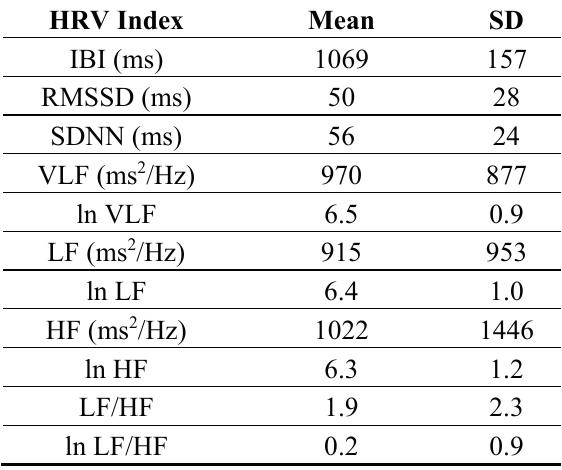
Table 2. Mean and standard deviations (SD) of heart rate variability (HRV) indices during nighttime sleep in blue-collar workers (n =